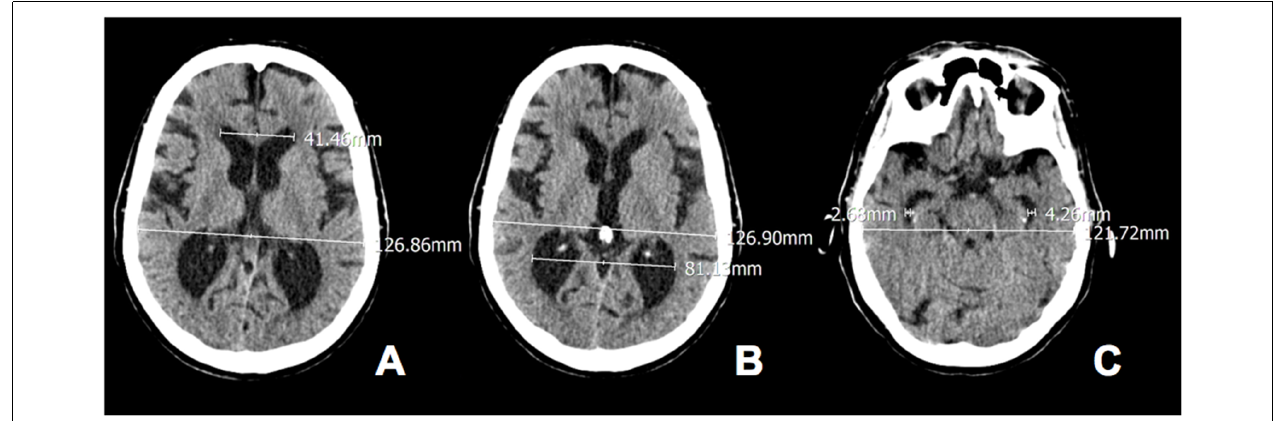
FIGURE 1 | Calculated Evan’s index, parieto-occipital ratio (POR) and temporal ratio (TR) in axial computed tomography (CT) scans of a 80-year old woman. (A) Evans’ index (EI) 41.46/126.86 = 0.33; (B) POR 81.13/126.90 = 0.64 and (C) TR 2.68 + 4.26/121.72 = 0.06.